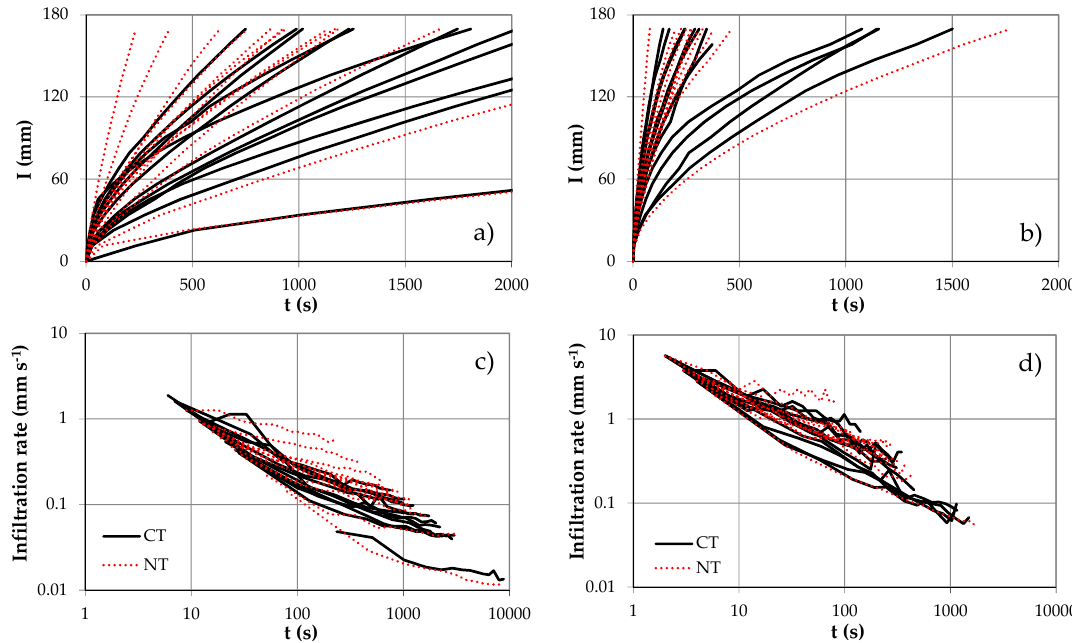
Figure 2. Cumulative infiltrations ( a , b ) and infiltration rates ( c , d ) at the study sites, Gravina (on the left) and Candela (on the right), under conventional tillage (CT) and no-tillage (NT). Note that I ( t ) relationship of Gravina was truncated at t = 2000 s; lost information can be assumed from Table 4.